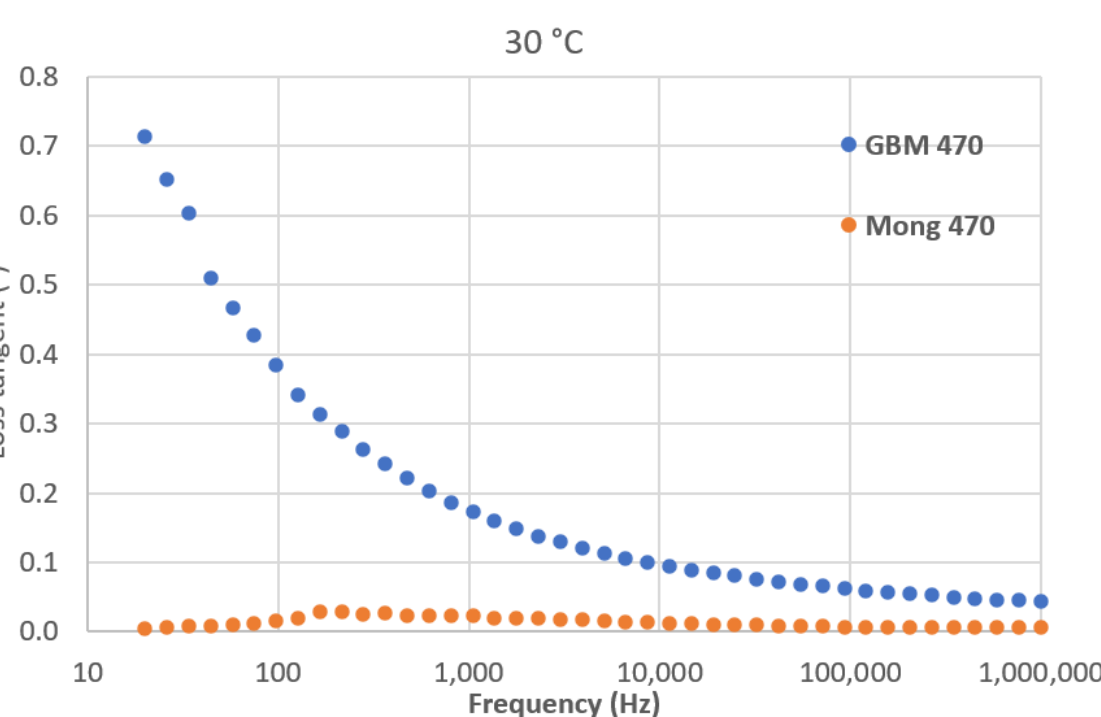
Figure 10. Loss tangent dependence on frequency at room temperature for coatings sprayed with SD 370.